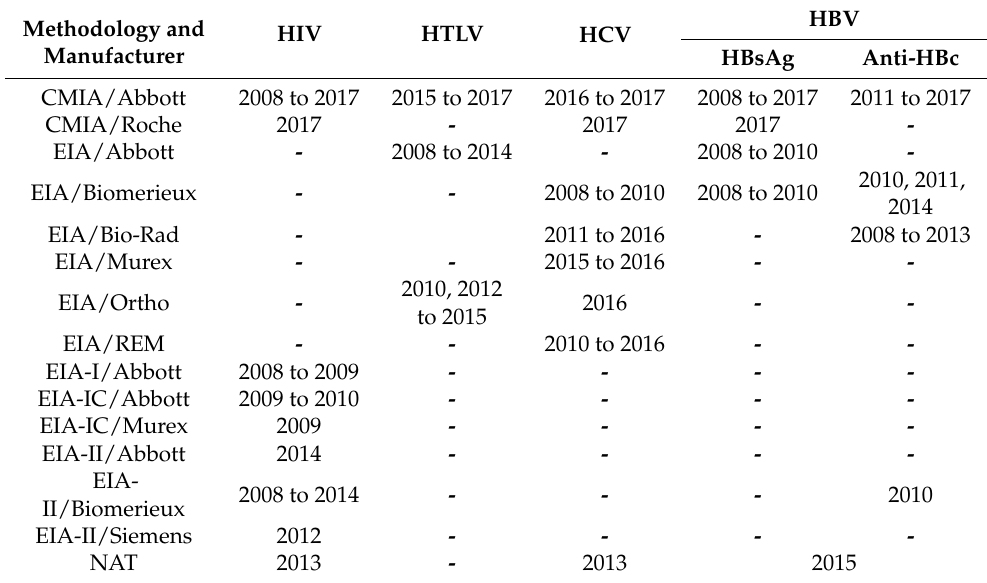
Table 1. Screening tests used at Hemoba from 2008 to 2017. Methodology